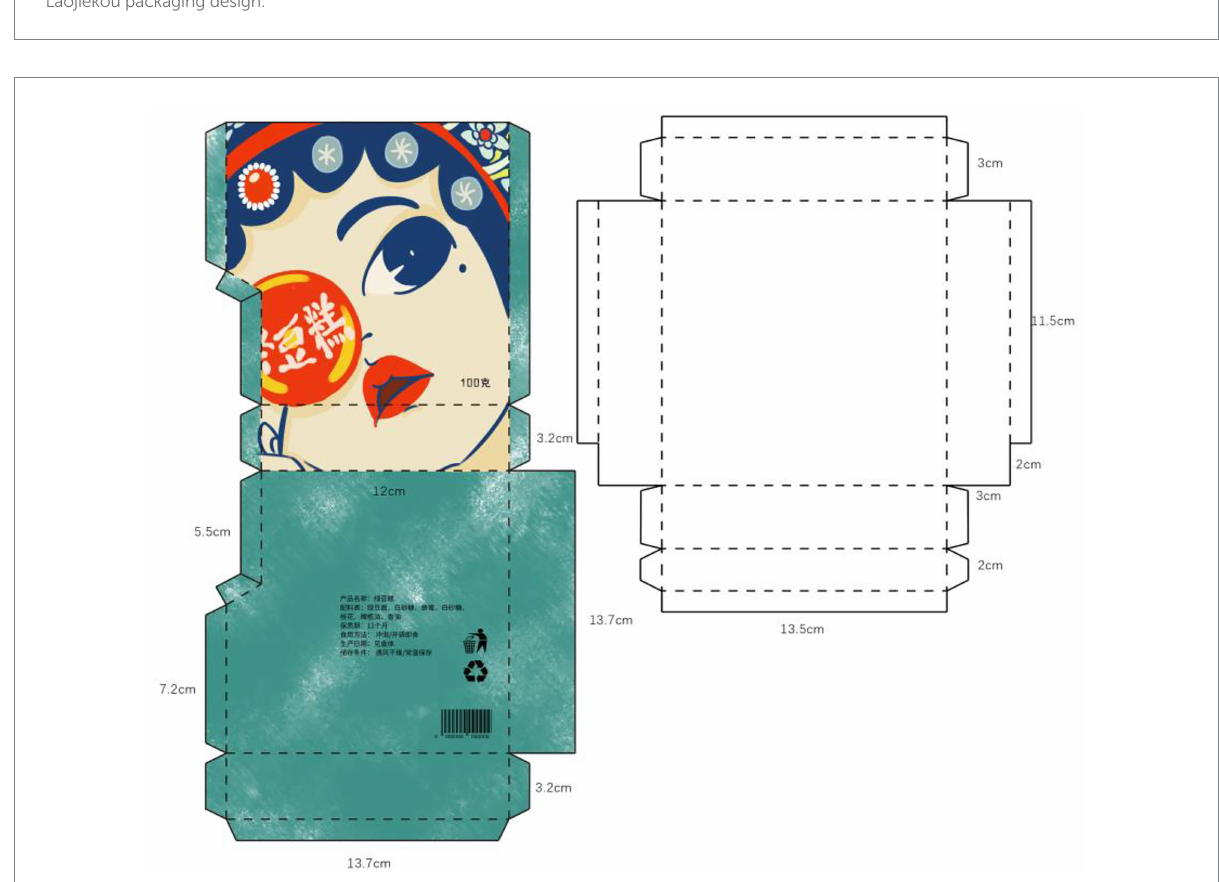
FIGURE 3 Mung bean cake packaging